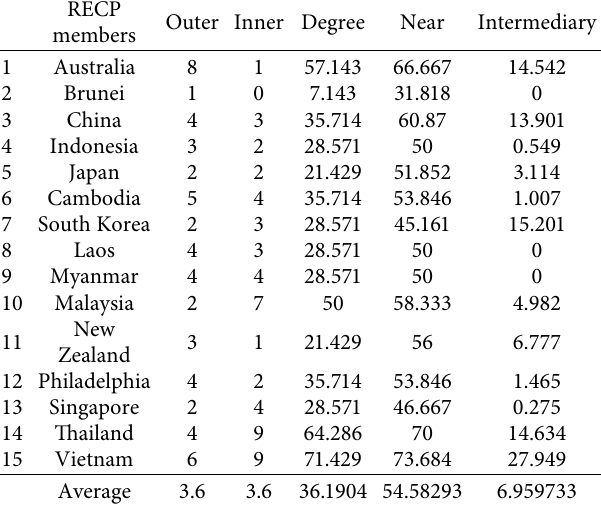
Table 1: RECP countries’ trade spatial connection